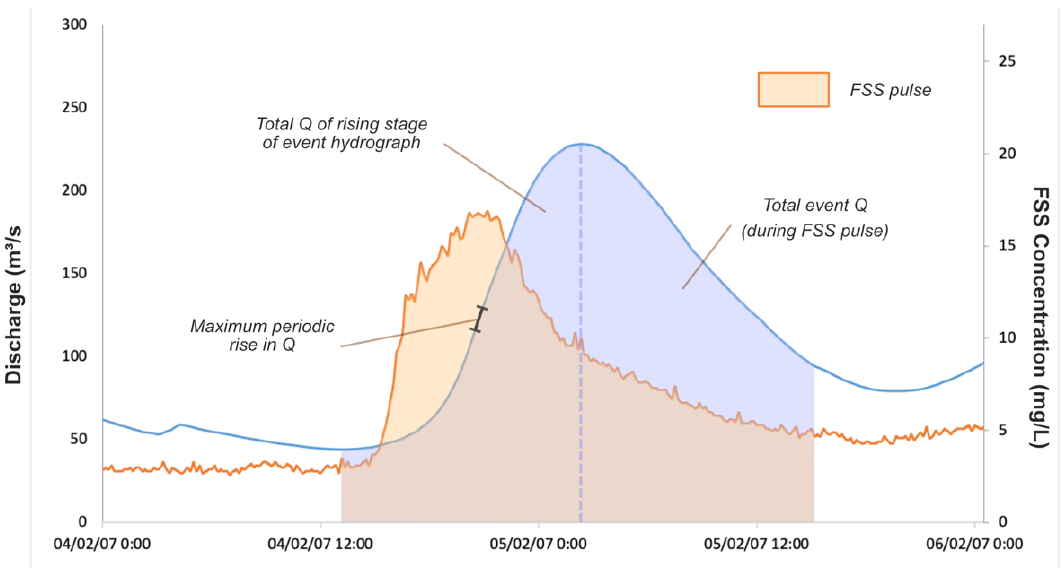
Figure 1. Schematic diagram showing hydrological characteristics determined for FSS pulse in Magela Creek.